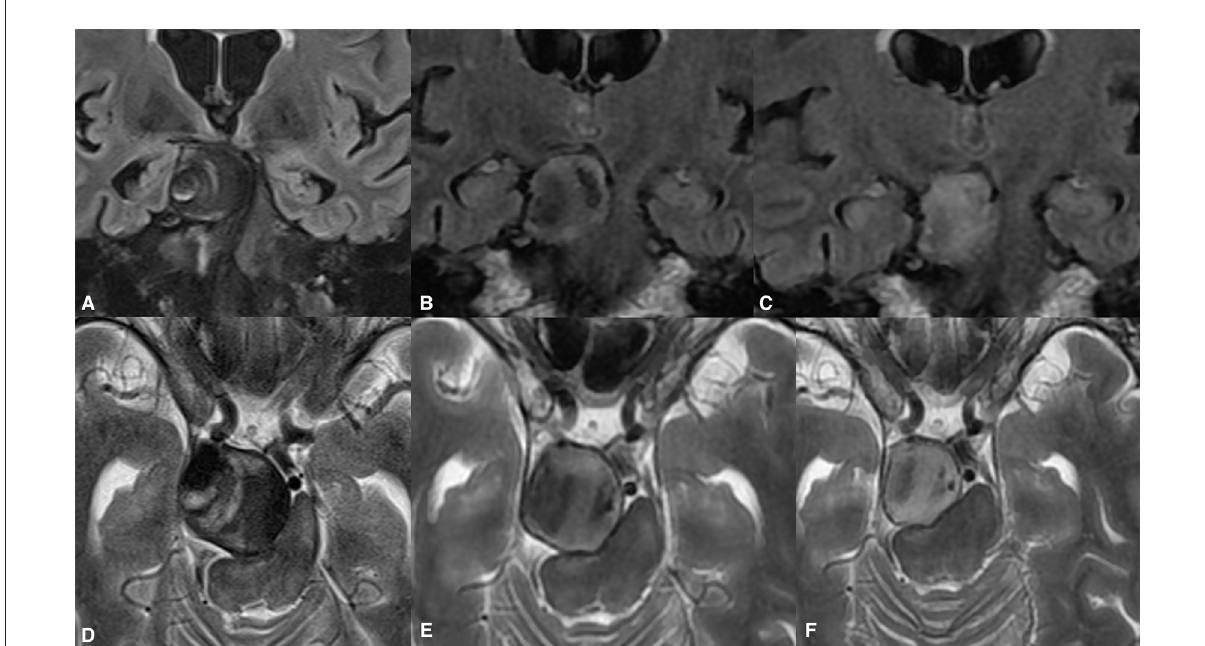
FIGURE5 Giant partially thrombosed cerebral aneurysm causing quadriparesis and obstructive hydrocephalus due to brain stem compression (A,D) . Significant post-treatment clinical improvement was confirmed due to alleviation of the brain stem compression (B,C) . The ongoing collapse of the aneurysmal sac with progressive intrasaccular T2WI signal changes was noted during the long-term follow-up (E,F)